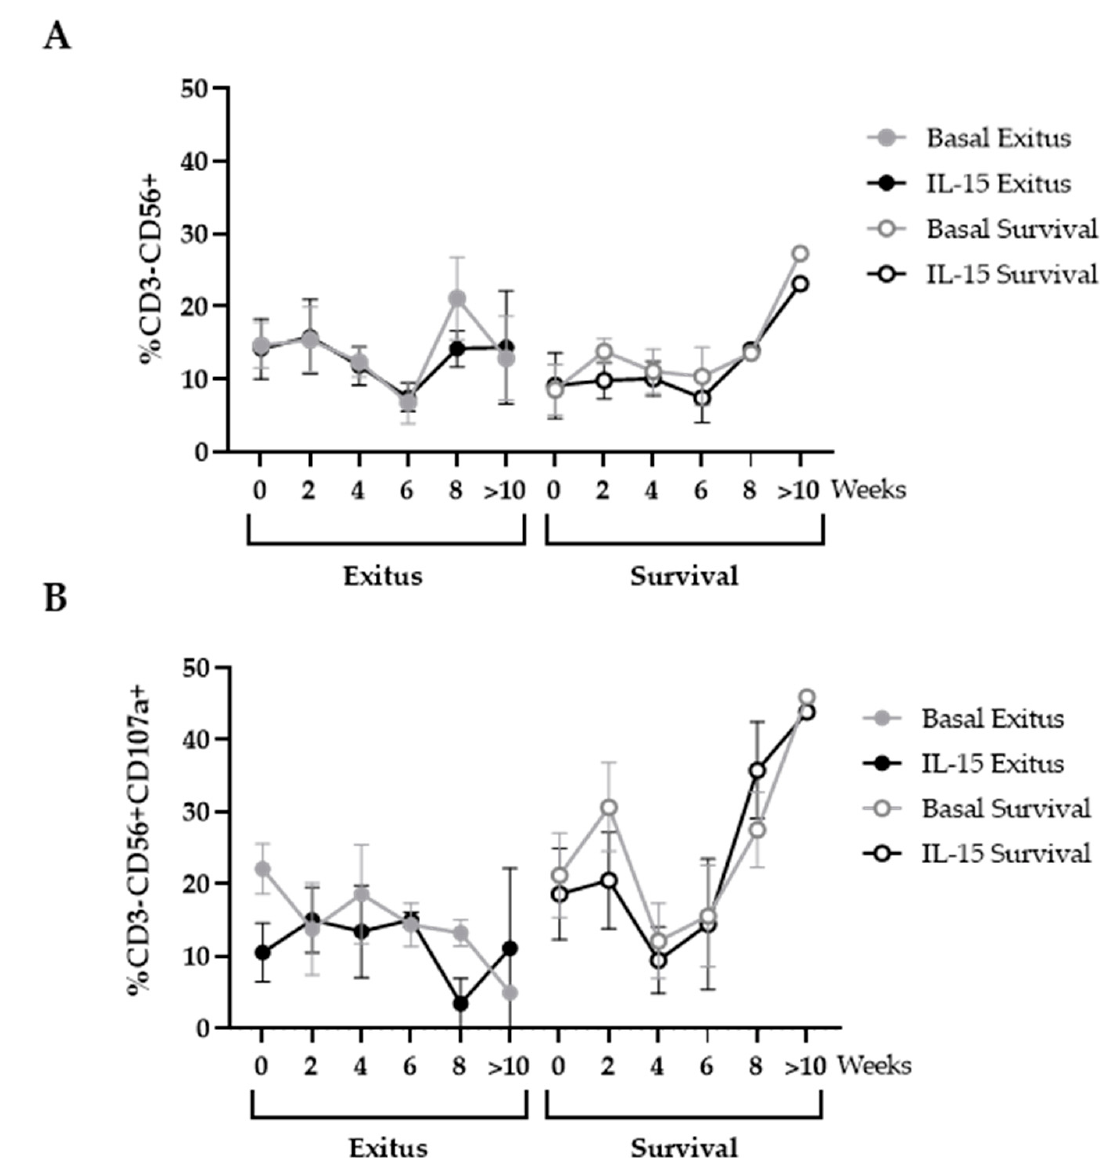
Figure 4. Levels of NK cells in PBMCs from individuals hospitalized with critical COVID-19. ( A ) Total levels of NK cells (CD3-CD56+) and ( B ) expression of the degranulation marker CD107a in these cells was evaluated in PBMCs in basal conditions (gray lines) or after treatment with IL-15 for 48 h (black lines) after co-culture (1:1) with Vero E6 cells infected with pseudotyped SARS-CoV-2 for 1 h. Each dot corresponds to the mean of data, and vertical lines represent SEM. Statistical significance between groups was calculated using Mann–Whitney U-test, and within groups, Wilcoxon U-test was used.